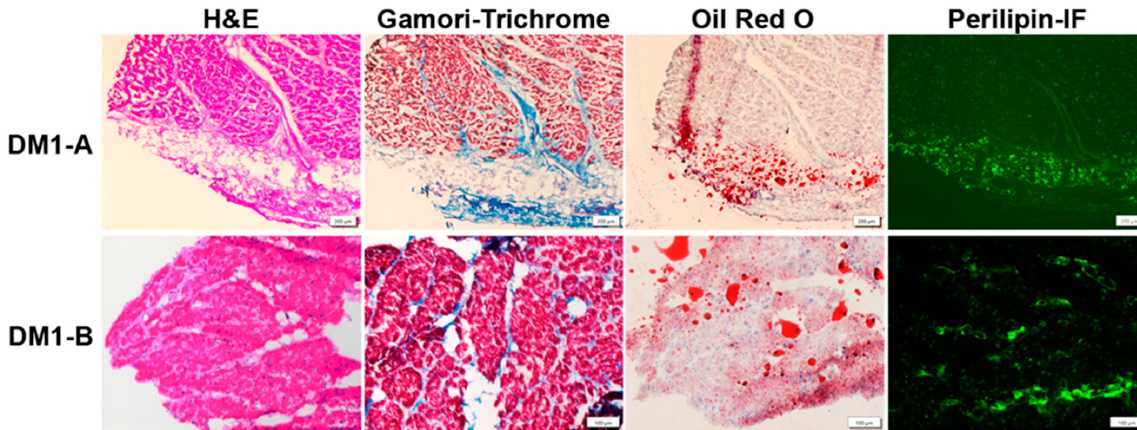
Figure 1. Cardiac Pathology in DM1. DM1-A (subendocardium) and DM1-B (myocardium) are autopsy specimens with evidence of typical cardiac pathology in DM1 showing interstitial fibrosis and fatty infiltration. H&E staining shows interstitial fibrosis (light pink regions) between cardiomyocytes as well as fatty infiltration (clear circumscribed areas in the middle of the tissue indicative of fat droplets). Gamori-trichrome staining highlights collagen (blue). Oil Red O staining detects lipids (red). Perilipin immunofluorescence (Perilipin-IF) (green) detects perilipin, a surface marker on fat droplets. Scale bar is 200 µm for above row and 100 µm for bottom row.